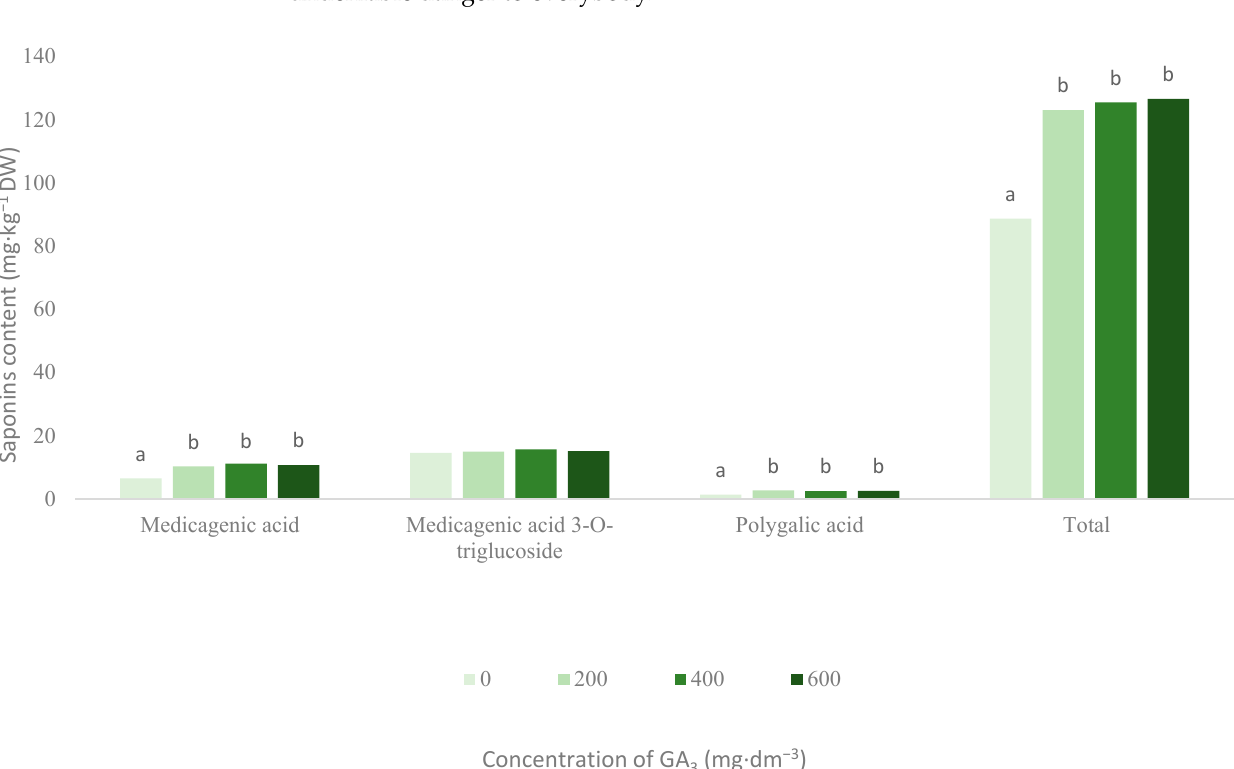
Figure 1. Saponins content of the Crocosmia × crocosmiiflora ‘Lucifer’ tubers after application of GA 3 . Means followed by the same letter do not differ significantly at α = 0.05.